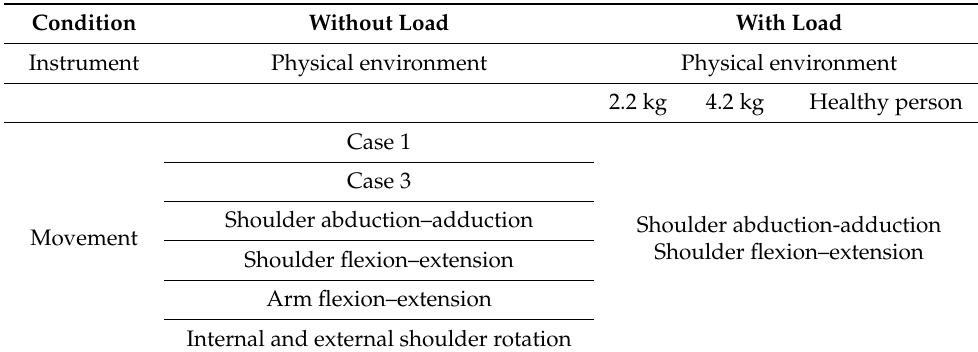
Table 3. Movements for each operating